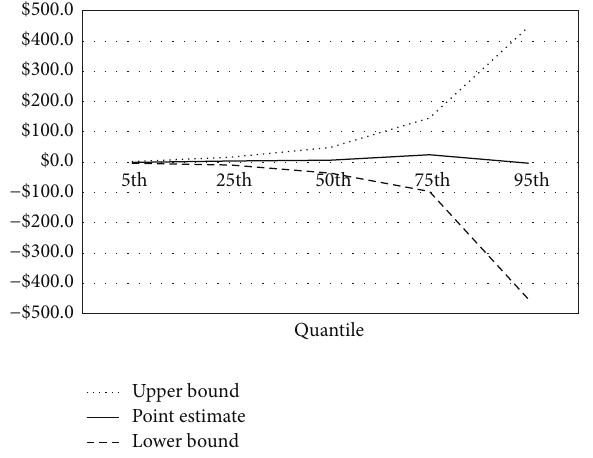
Figure 4: Weighted relationships between residence and nonzero expenditure of prescription drug, adjusted by 10 covariates.